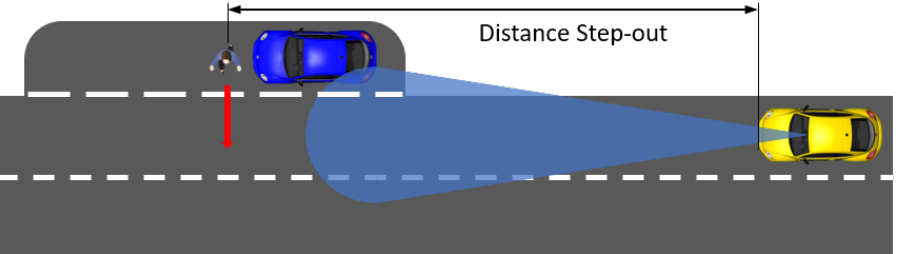
Figure 3. Pedestrian step-out scenario with the yellow ego vehicle, the pedestrian and a static blue vehicle, which acts as an obstruction so that the pedestrian is only seen once they step onto the driving